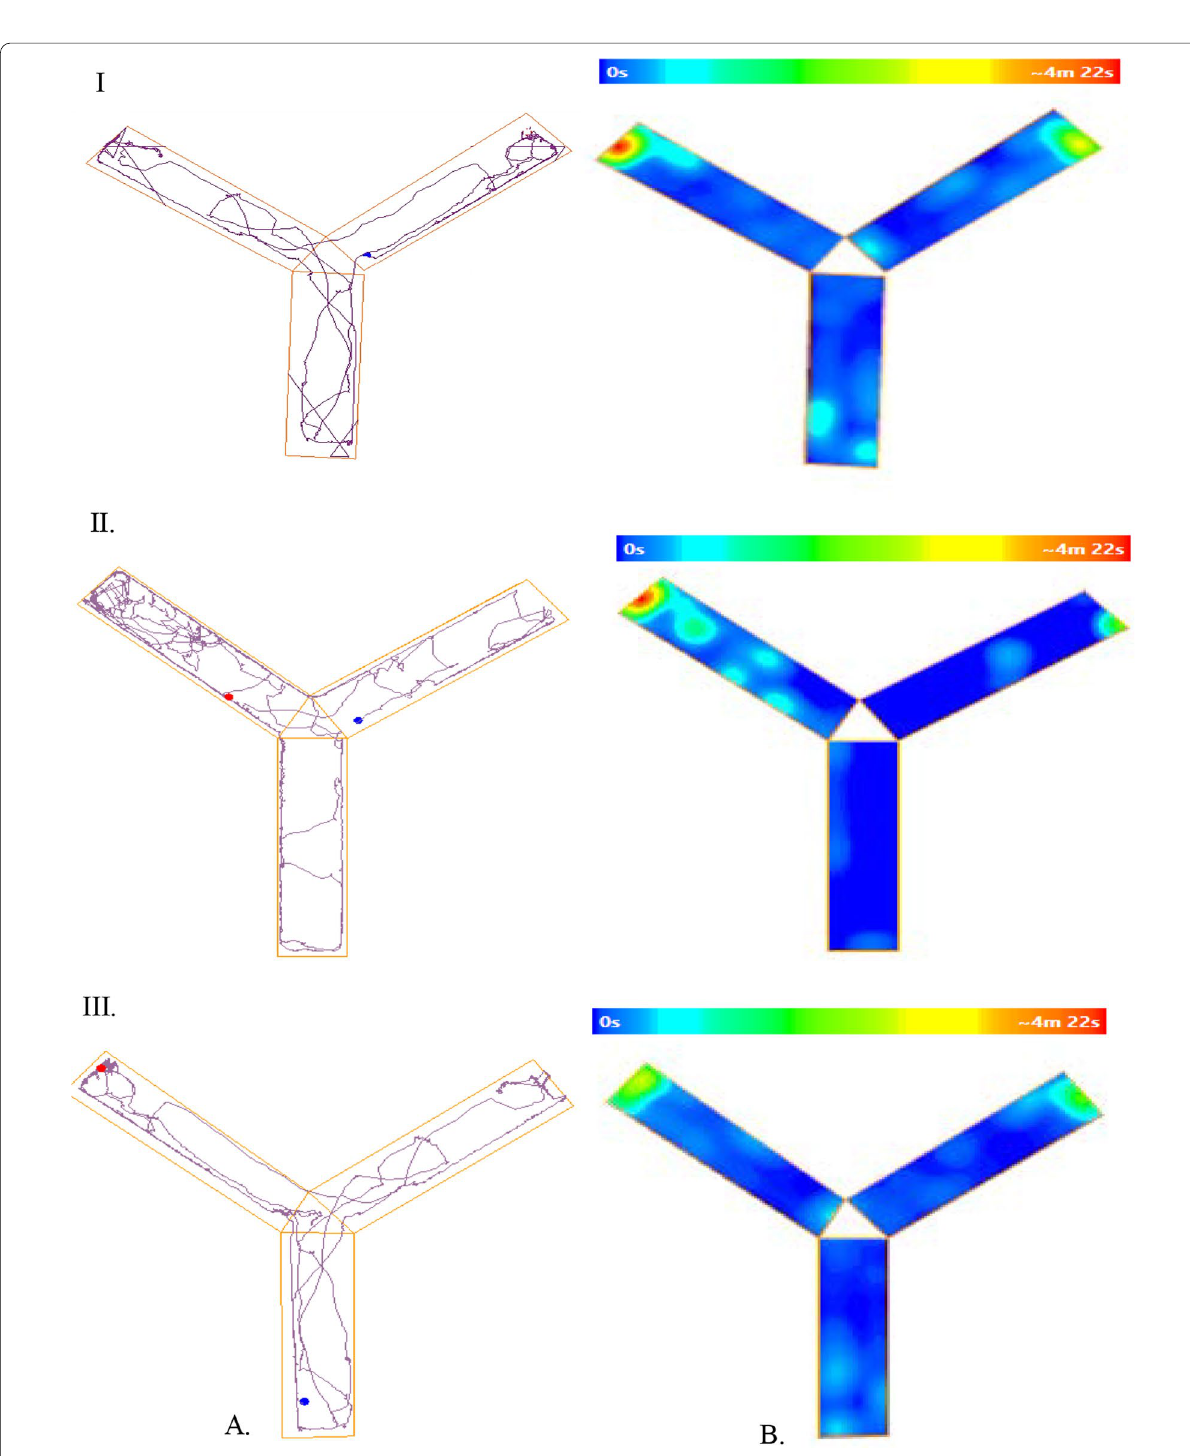
Fig. 6 Track ( A ) and heat ( B ) map visualizing the path followed and time spent by 1st ( I ), 2nd ( II ) and 3rd ( III ) instar individual C. carnea in movement area for ten minutes. Vertical arm is a release arm, where Y-maze provided with C. carnea eggs at left arm and of S. cerealella eggs at right arm. Blue and orange spots are starting and ending point, respectively. Data were analyzed using video tracking software (ANY-maze ® , Stoelting CO,